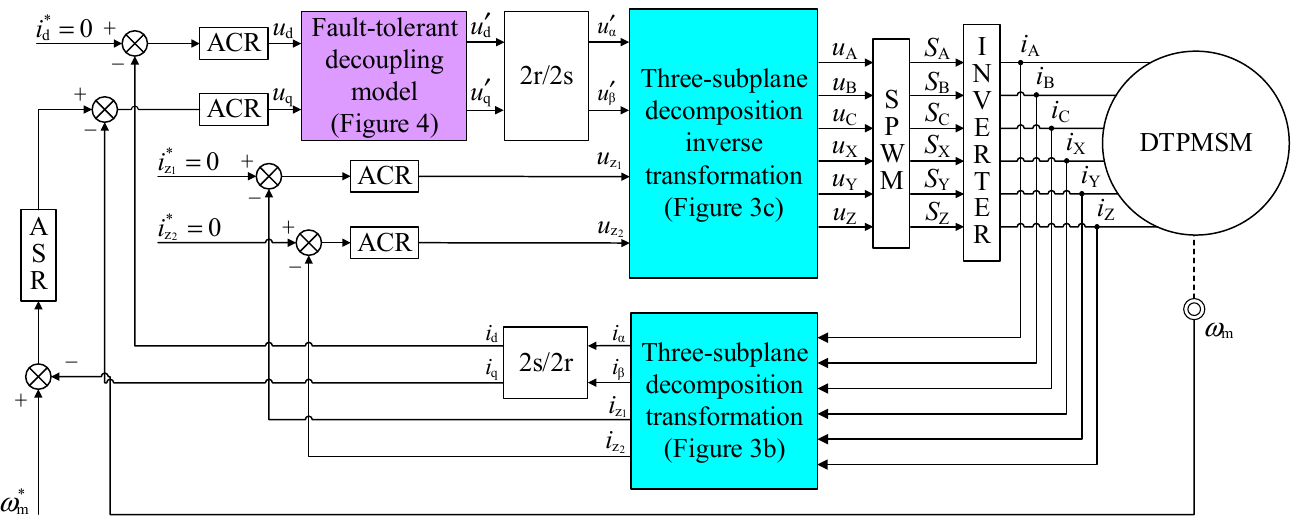
Figure 5. The block diagram for TSC control of post-fault dual three-phase PMSM.